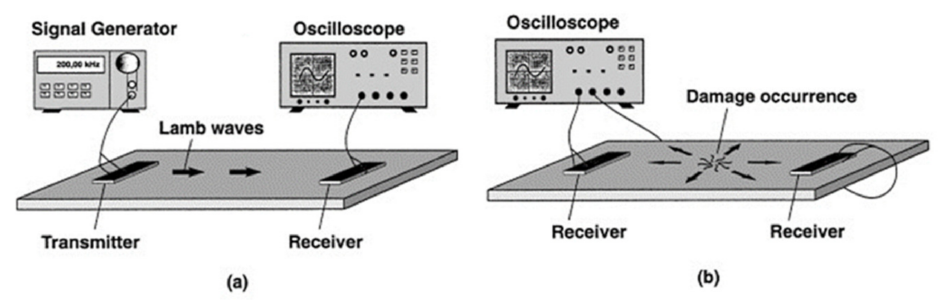
Figure 11. ( a ) Set-up of the Lamb wave analysis and ( b ) principle of the AE